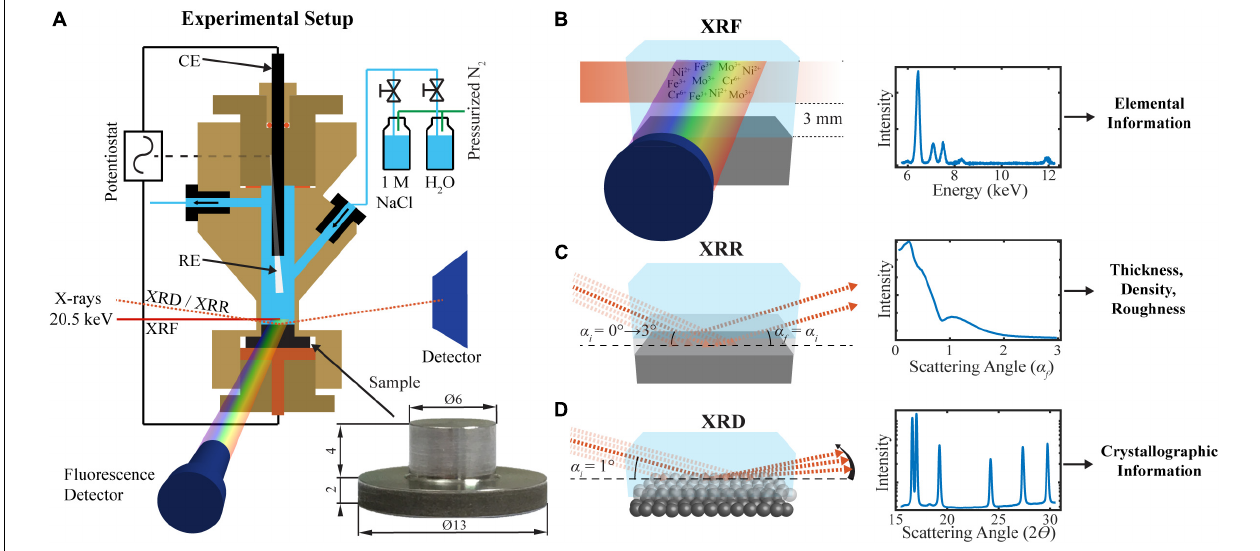
FIGURE 2 | Schematic illustration of the experimental setup for electrochemical operando XRR/XRD/XRF measurements of 2507 DSS in 1M NaCl solution: (A) The three-electrode electrochemical cell, the sample dimensions, and the inlet and outlet of gas or liquid. (B) The XRF, (C) XRR, and (D) GIXRD measurements. The saturated Ag/AgCl reference electrode (RE), a glassy carbon counter electrode (CE), and a sample as the working electrode are connected to a potentiostat [reprint with permission (Långberg et al.,